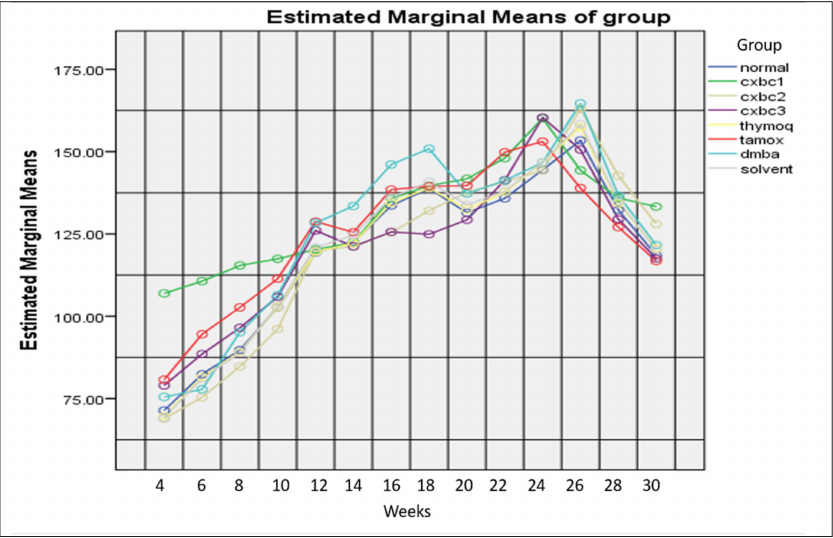
Figure 5. Development of DMBA-induced SD rat body weight by administering CXBCH preparations.